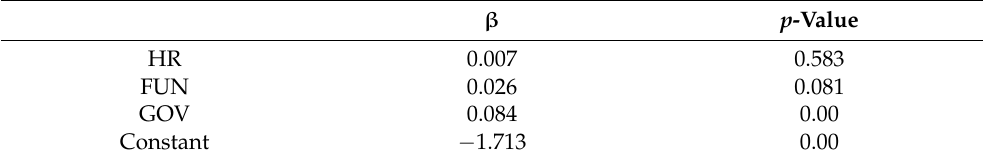
Table 10. Logistic regression results for COM2 (use of cutting-edge technology) independent variable.